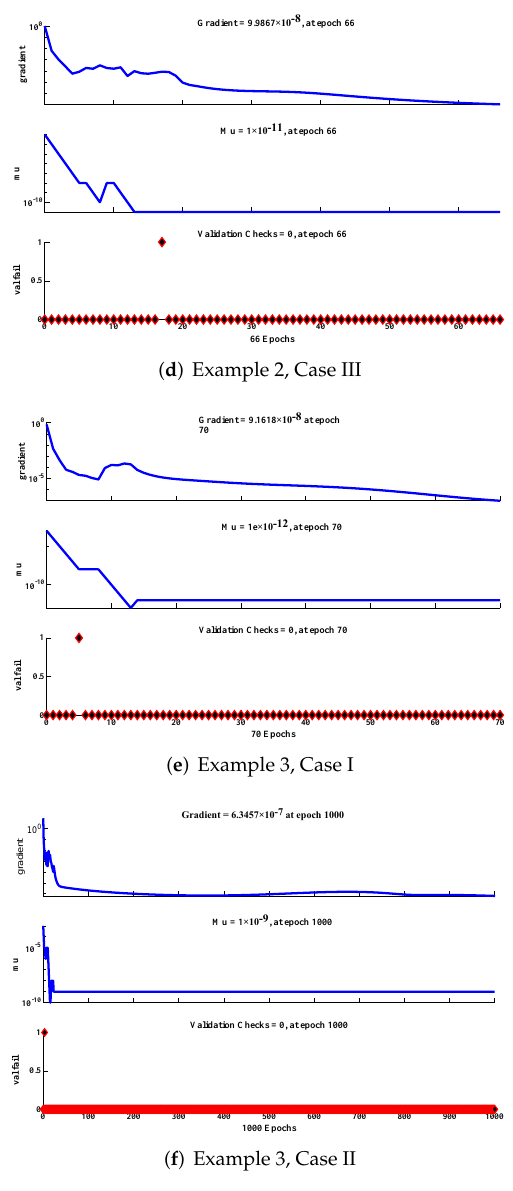
Figure 15. Training state of the design scheme for all examples of the rolling